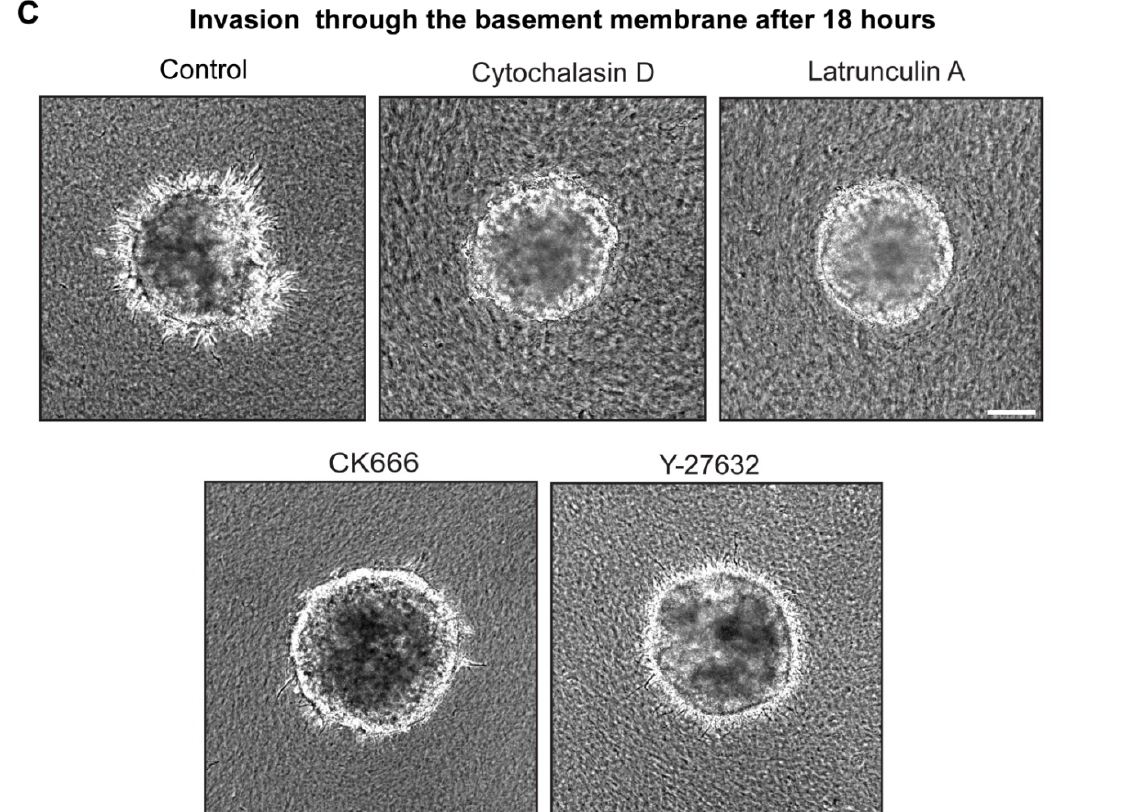
Figure 5. Contribution of actin polymerization to basement membrane perforation during collective cancer cell invasion. ( A ) Confocal immunofluorescence images of the basement membrane (anti- collagen IV antibody) after treatment with the following inhibitors: cytochalasin D (actin), latrunculin A (actin), CK-666 (ARP2/3), or Y-27632 (ROCK). ( B ) Quantification of basement membrane perfora- tion areas for each treatment at 18 h. ( C ) Brightfield images of the spheroids after each treatment, showing the effects of the inhibitors on cell invasion. **** p < 0.0001. These graphs and images are based on pooled data from at least 3 independent experiments, each including at least 3 spheroids per experiment, all of which showed similar results. Scale bars: ( A ), 10 µ m; ( C ), 100 µ